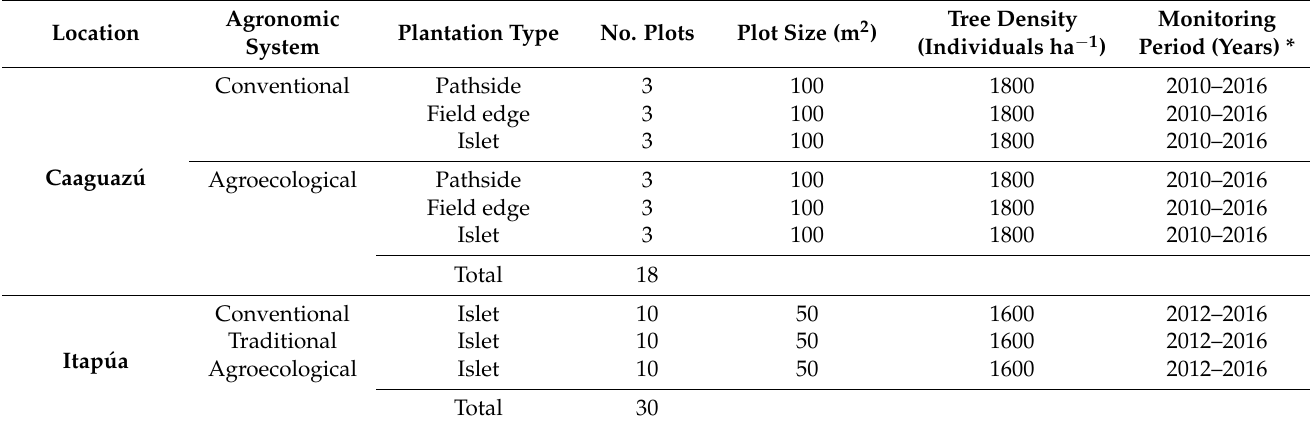
Table 1. Experimental plantations established at the study